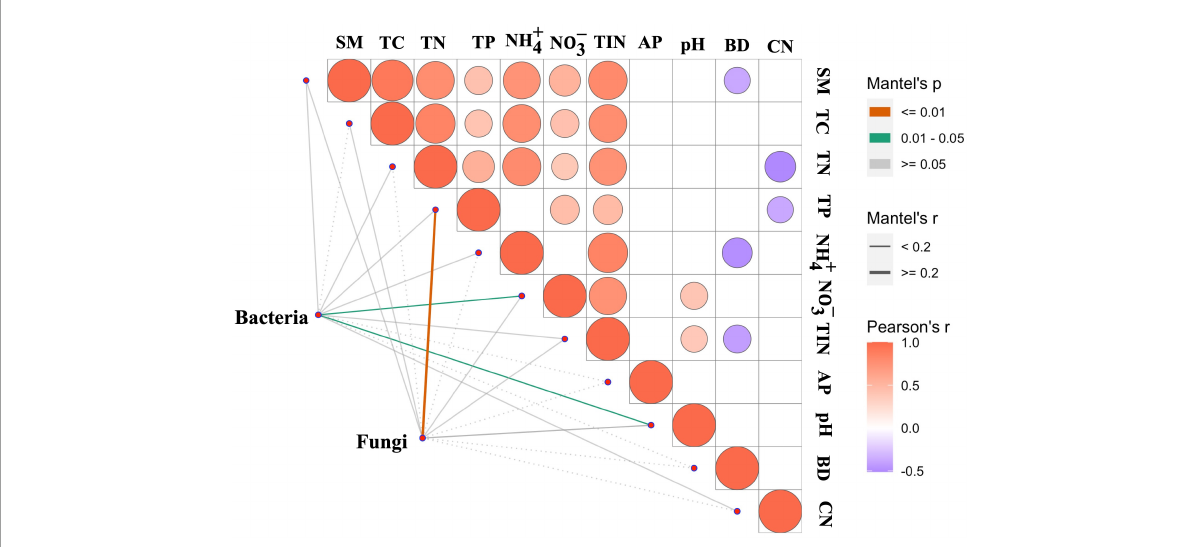
FIGURE5 Mantel’s correlation for testing the relationship between soil properties and bacterial and fungal community composition across the nutrient treatments. TC, total carbon; TN, total nitrogen; TP, total phosphorus; BD, bulk density; AP, available phosphorus; SM, soil moisture; TIN, total inorganic N; CN, the ratio of TC:TN.